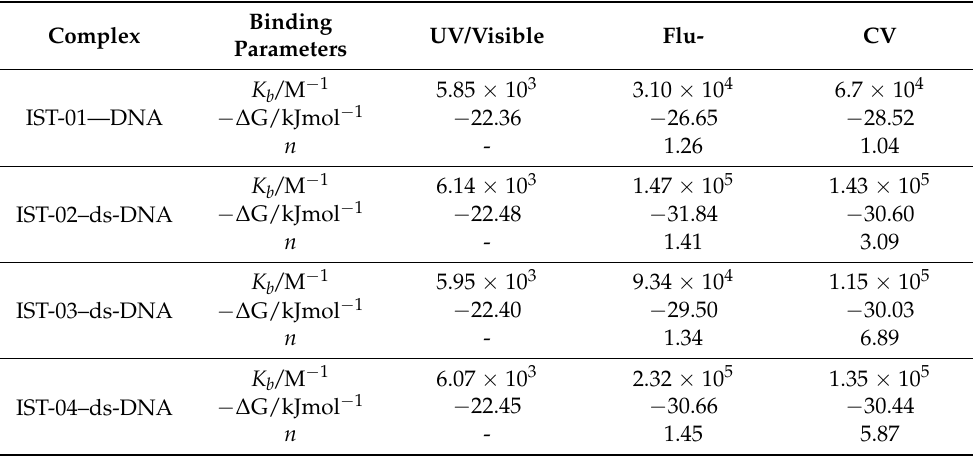
Table 3. Binding parameters obtained from UV-visible spectroscopy, fluorescence (Flu-) spectroscopy and cyclic voltammetry